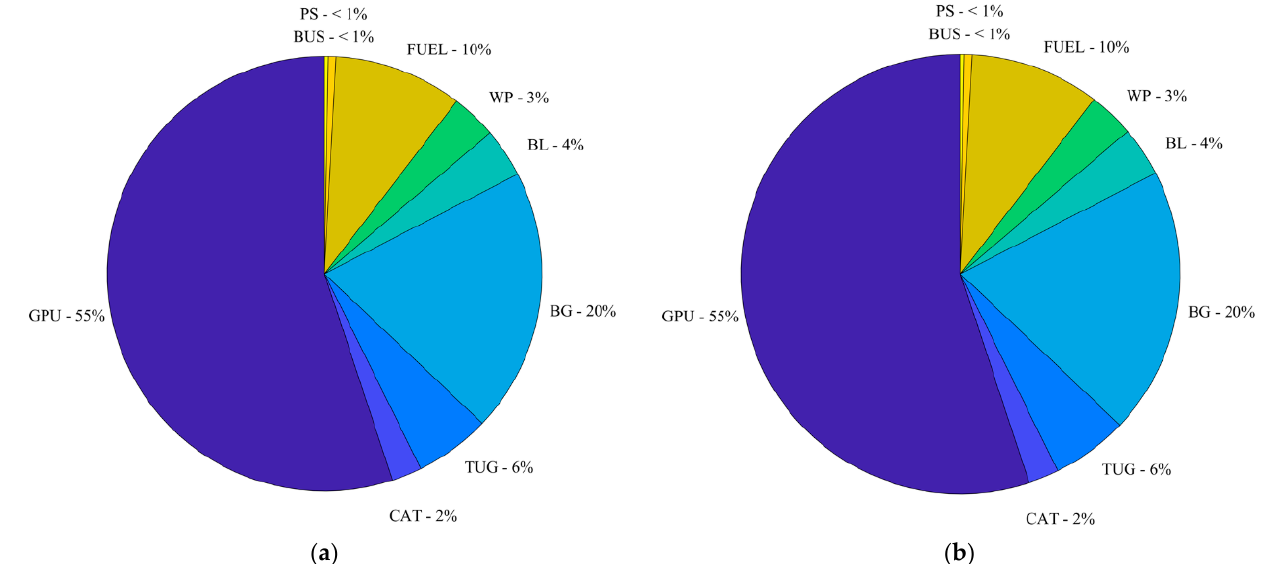
Figure 11. Emissions per GSE, ( a ) CO, ( b ) NOx.